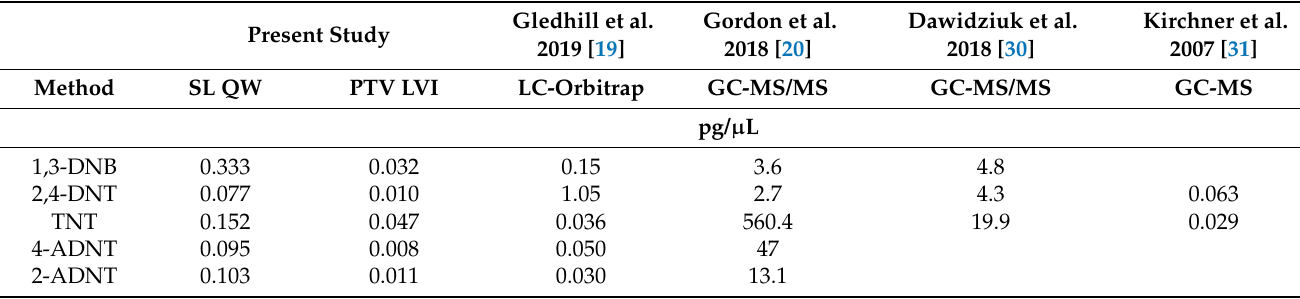
Table 5. Comparison of the instrumental detection limits (pg/ µ L) achieved in this study with those published by other